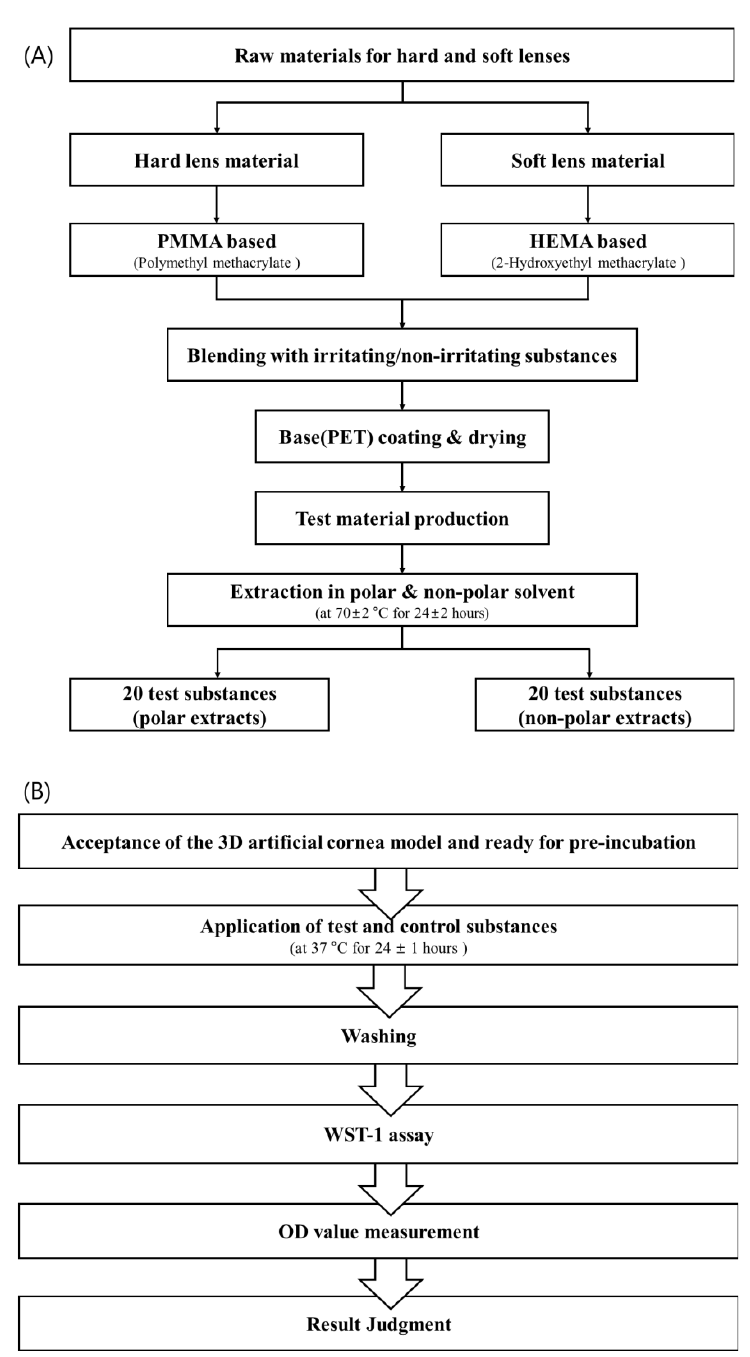
Figure 1. Test substance preparation flow chart and study design. ( A ) Preparation of test substances and ( B ) eye irritation test procedure using MCTT HCE ™ .